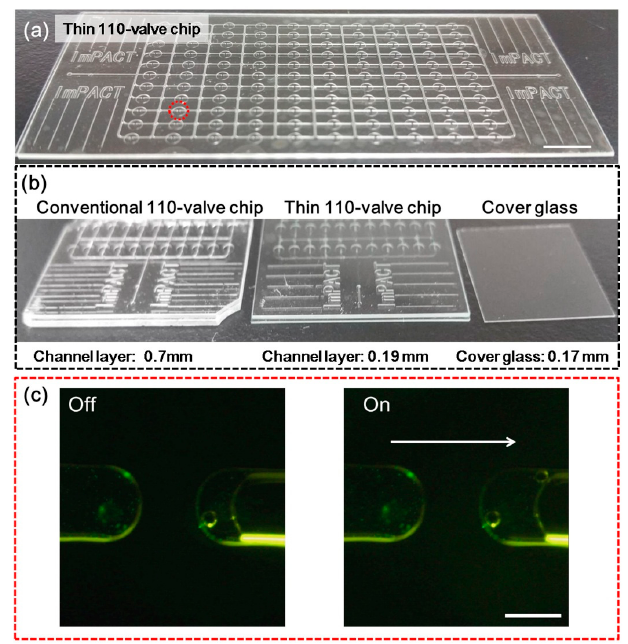
Figure 10. Comparison and confirmation of the thin version all-glass valve chip. ( a ) Thin version of the all-glass valve chip; ( b ) Photos of a conventional all-glass valve chip ( left ), thin version of the all-glass valve chip ( middle ), and a cover glass ( right ); ( c ) Valve actions of the thin version of the all-glass valve chip were confirmed. The off/on action of the valve in the red dotted circle of ( a ) was captured from Video S9. The white scale bar is 0.1 mm.